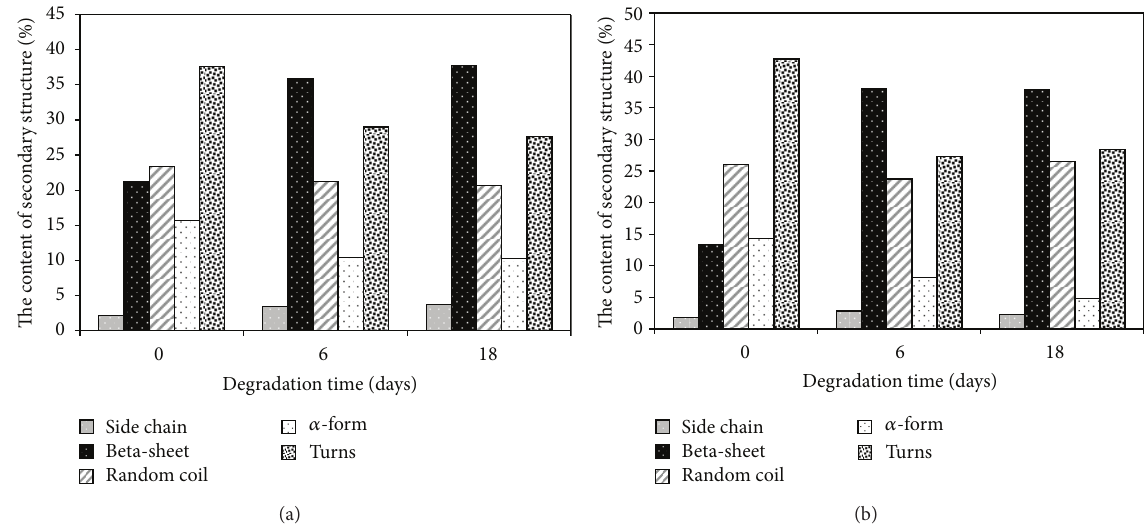
Figure 6: The content of secondary structure of scaffolds after enzymatic degradation for 0, 6, and 18 days (a) unmodified; (b)